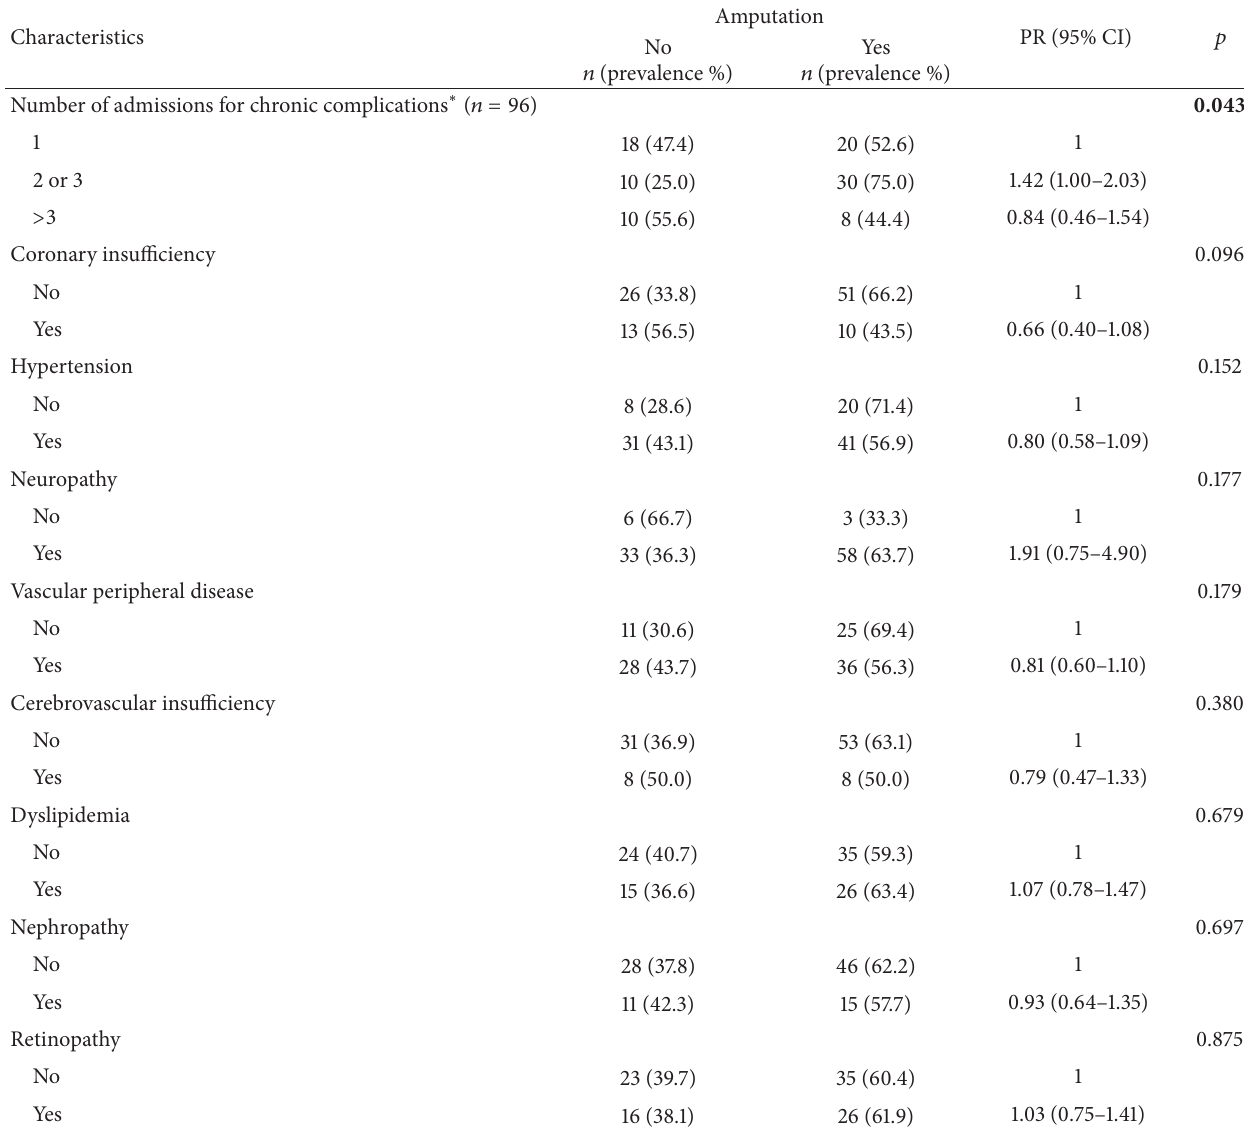
Table 2: Distribution of patients with diabetes by comorbidity occurrence in relation to diabetic foot amputation.